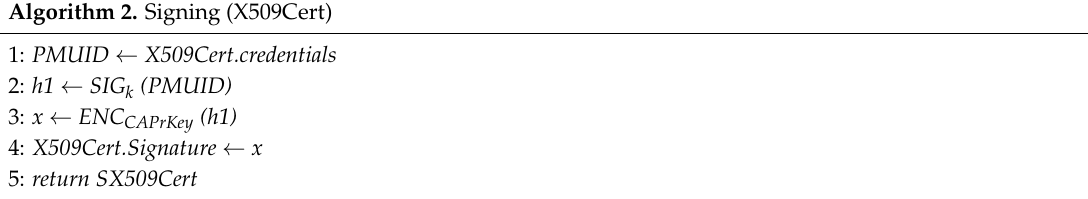
Algorithm 2. Signing (X509Cert)